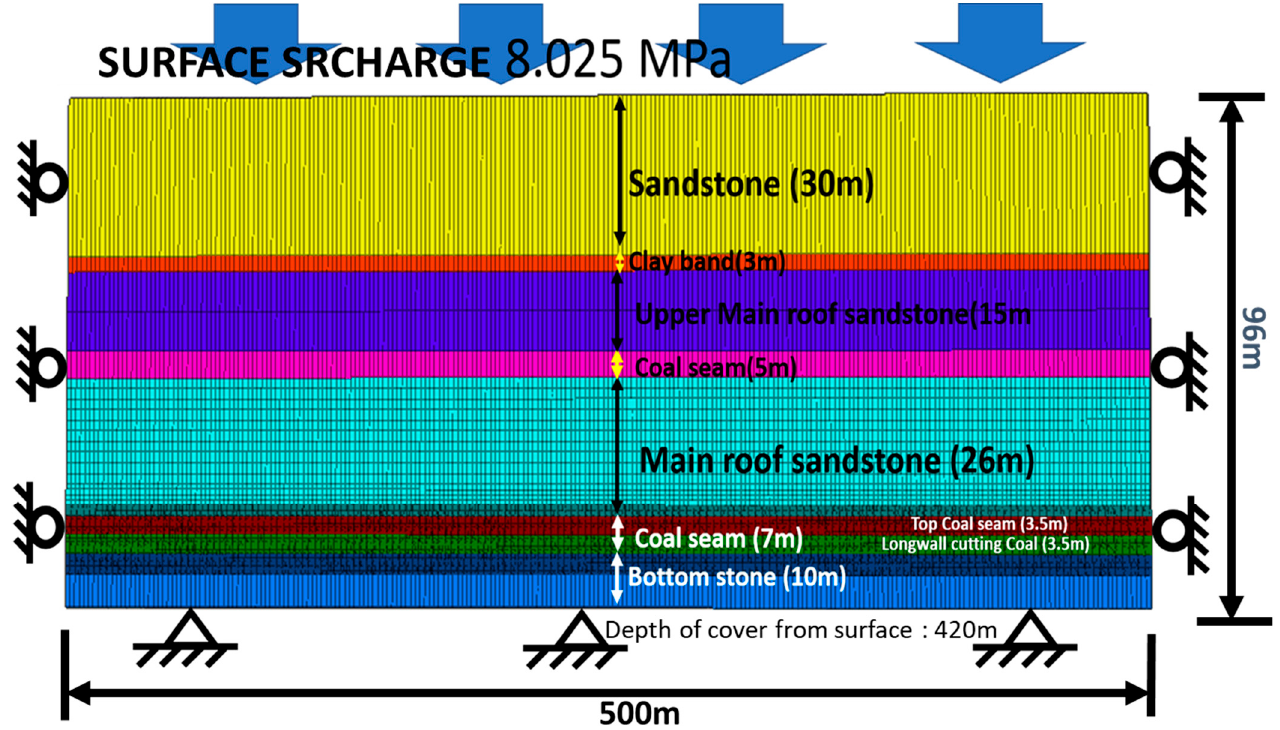
Figure 1. Basic constitutive model.